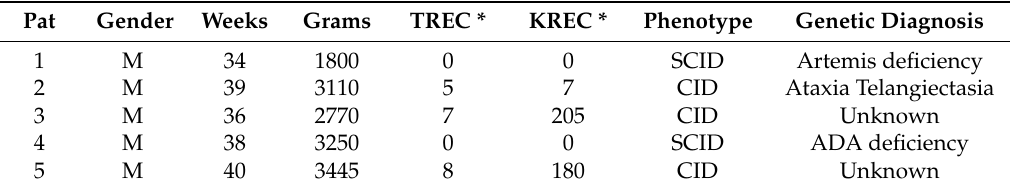
Table 2. True positive